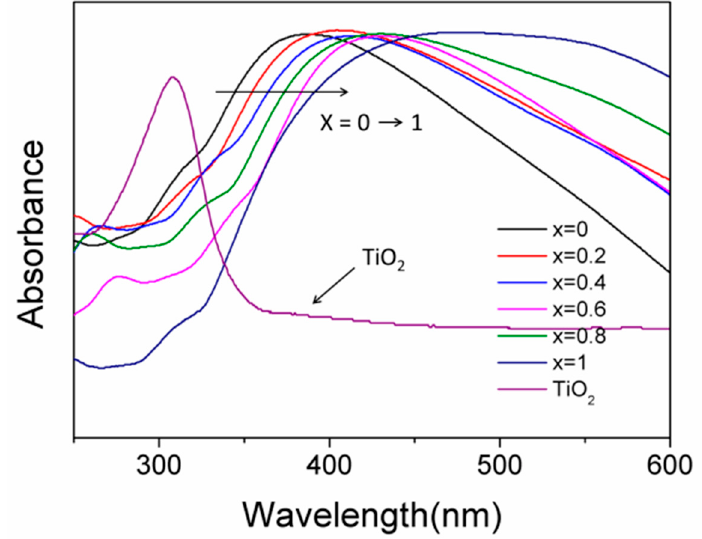
Figure 5. UV–vis spectra of Au x Ag (1 − x ) /TiO 2 composites ( x = 0, 0.2, 0.4, 0.6, 0.8, and 1) and the pure TiO 2 spheres.